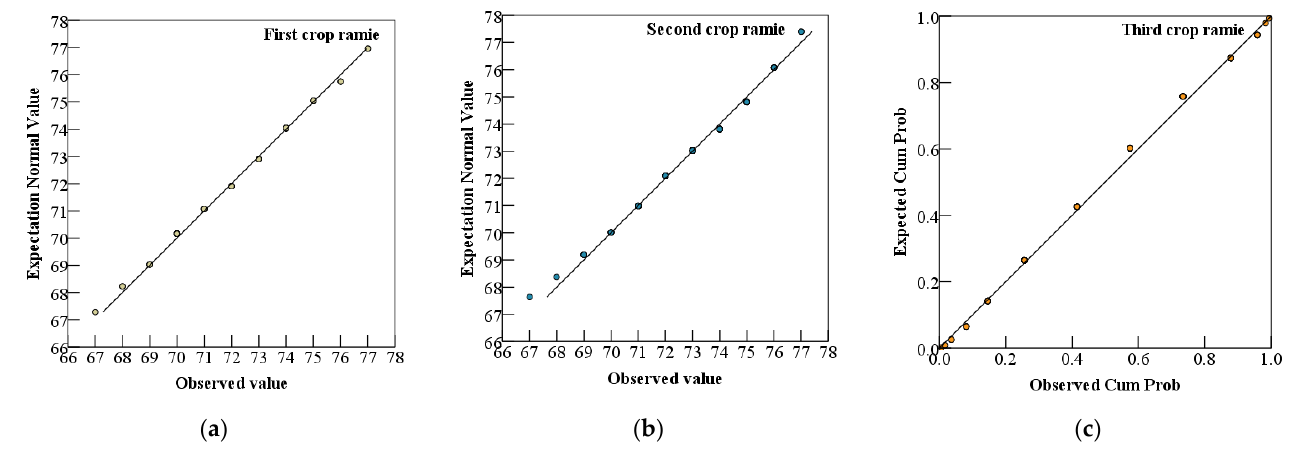
Figure 4. Normal Q – Q Plot of three crops of ramie. ( a ) First crop ramie; ( b ) Second crop ramie; ( c ) Third crop ramie.